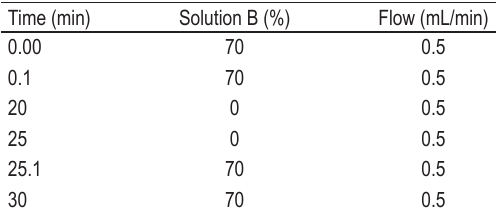
TABLE 1. The program of gradient